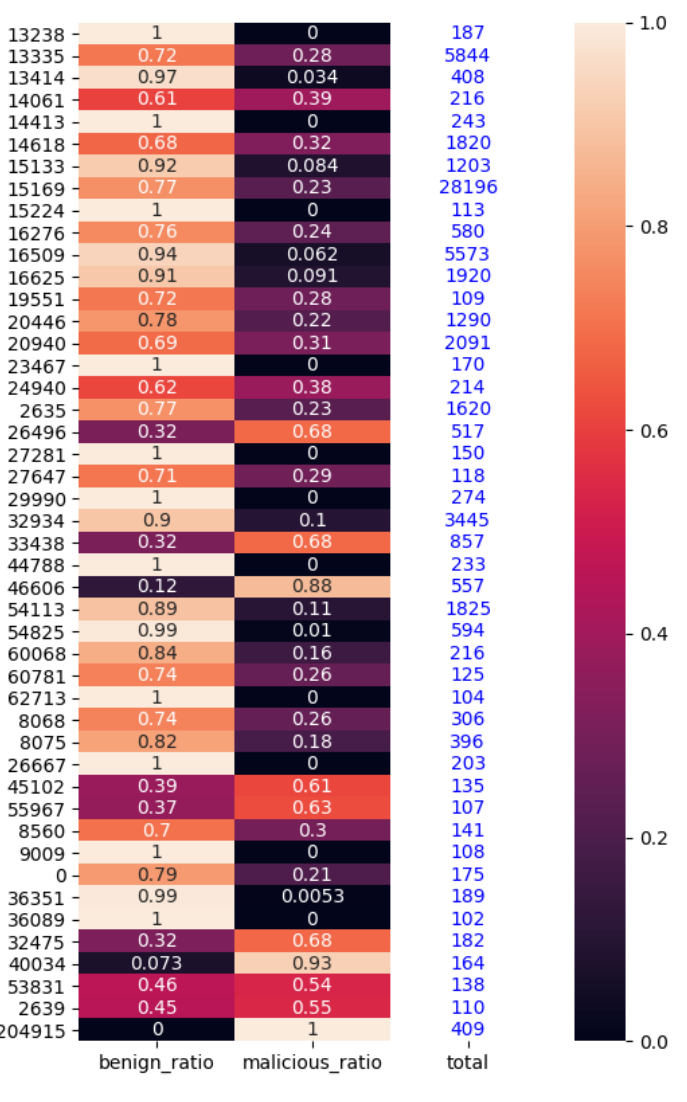
Figure 5. Communication ASNs